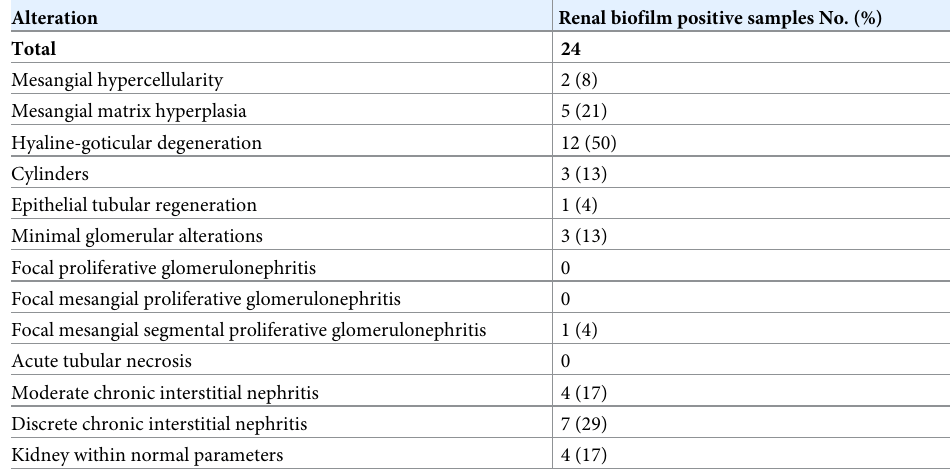
Table 2. Histopathological alterations observed in chronically infected Rattus norvegicus with the presence of renal biofilm.